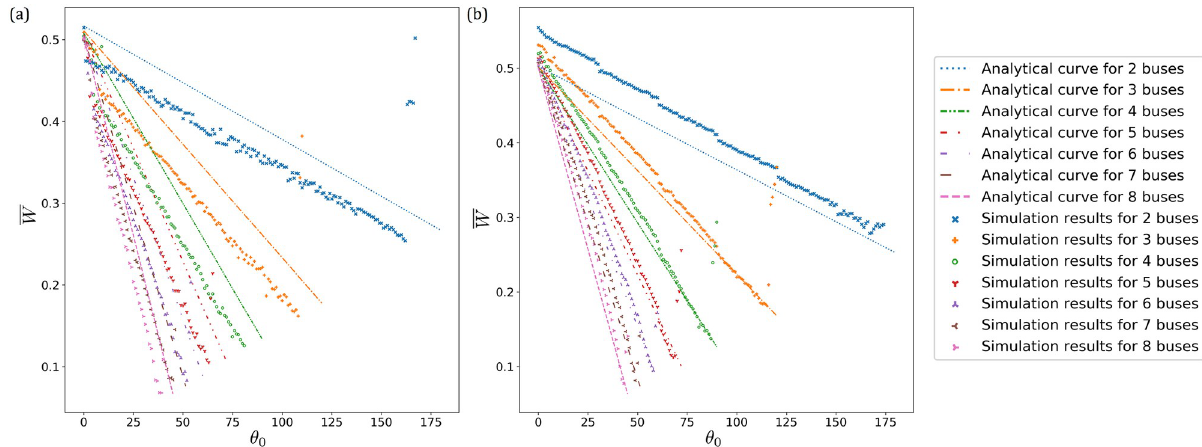
Fig 7. (a) Simulation results for N = 2, 3, 4, 5, 6, 7, 8 buses, respectively, serving M = 1 bus stop. The demand level is fixed at k = 1/16. (b) Simulation results for N = 2, 3, 4, 5, 6, 7, 8 buses, respectively, serving M = 12 bus stops. The demand level is fixed at k = 1/100. The analytical curves are those serving M = 1 bus stop. The simulation points have average waiting times which are higher than their corresponding analytical curves, since these buses serve M = 12 bus stops. Furthermore, there are discrete jumps on the simulation points whenever an extra bus stop is present.